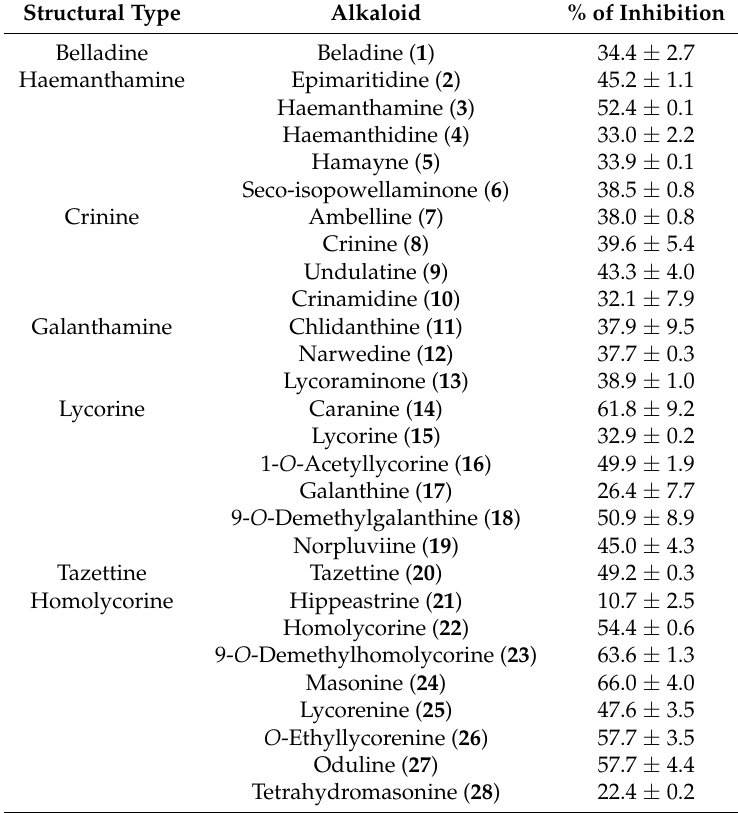
Table 1. Screening of Amaryllidaceae alkaloids for their potency to inhibit GSK-3 β (conc. 50 µ